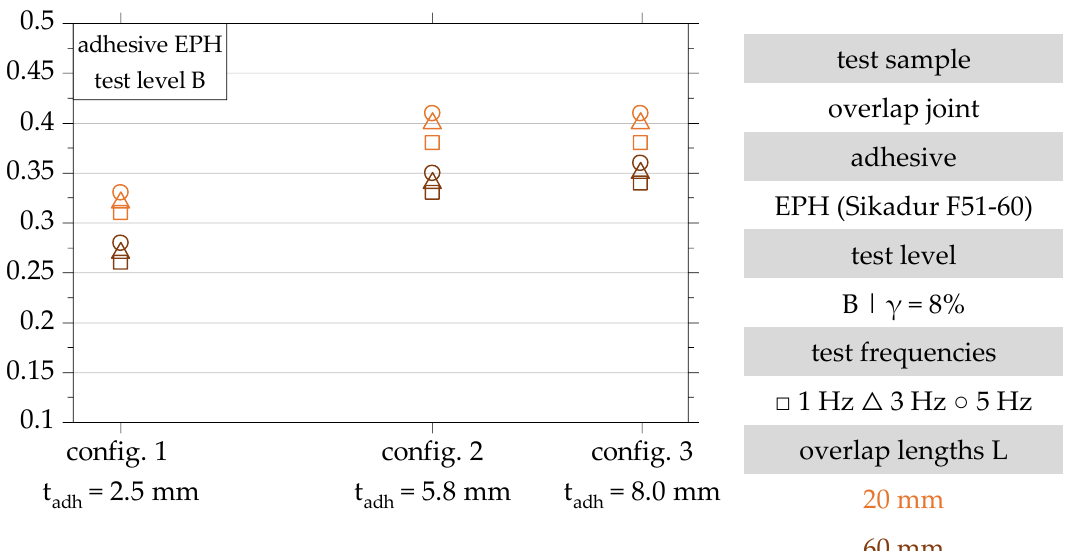
Figure 8. Results of the dynamic investigation of the damping characteristics of the overlap joint configurations 1, 2 and 3 for the determination of the loss factor in test level B ( γ = 8%) in accordance with [22].